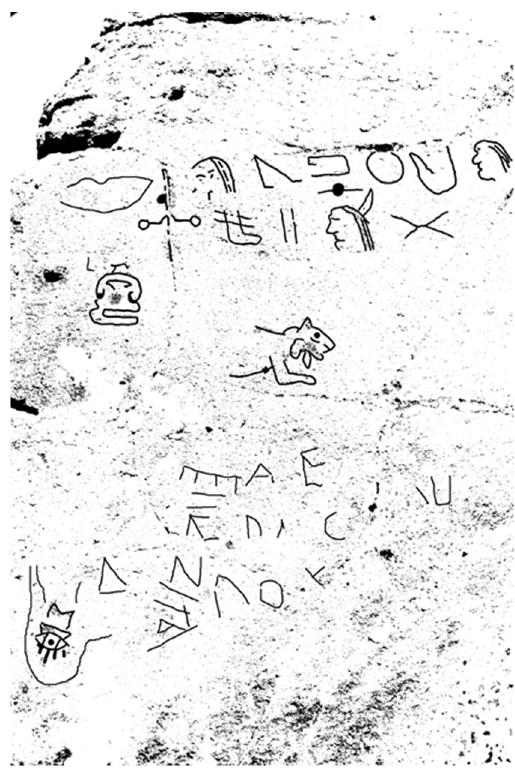
Figure 27. Del Norte, Colorado. The Maya negation sign appears in the first position of line 2. The weeping-eye is inscribed in a “Ghost Handprint”. Digital tracing from photo.